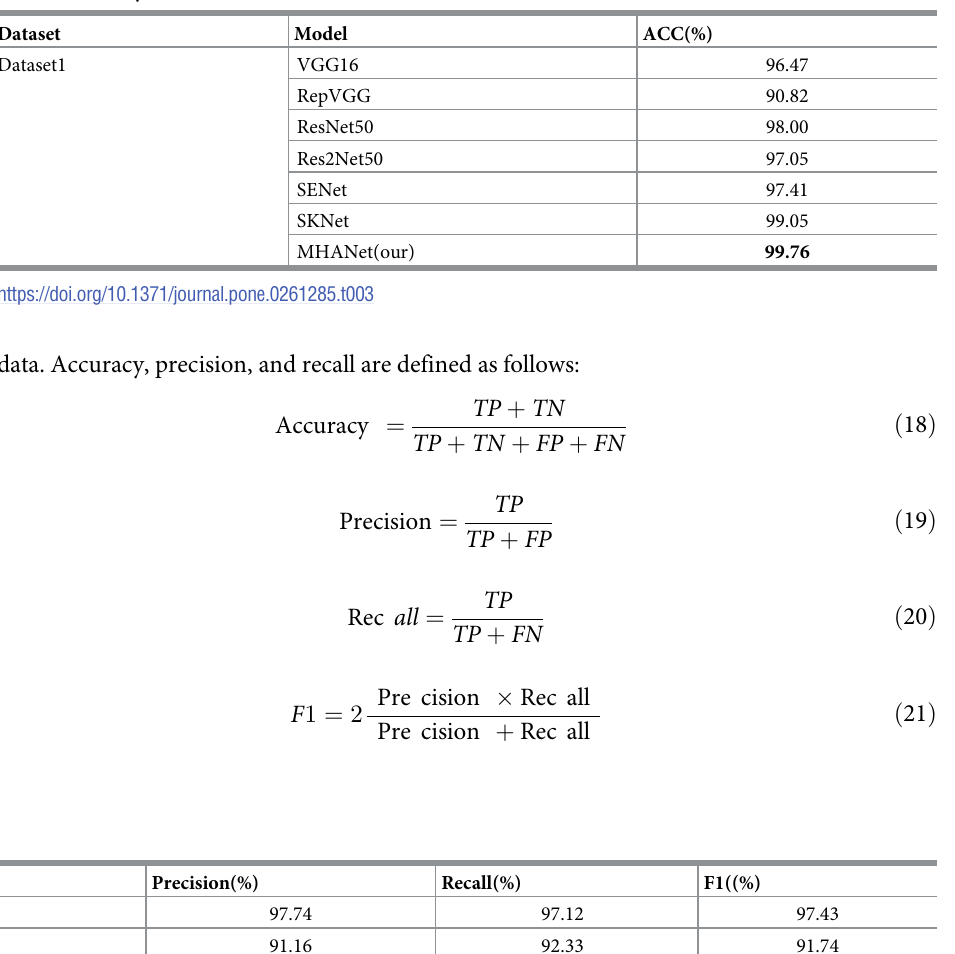
Table 3. Accuracy of Dataset1.